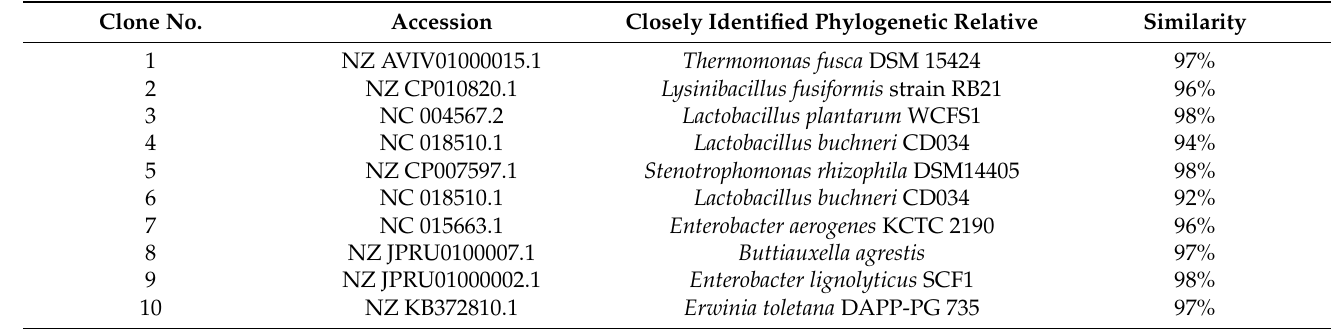
Table 7. Sequences analysis of DNA recovered from single band in DGGE fingerprints of silage after aerobic exposure for 3 days.